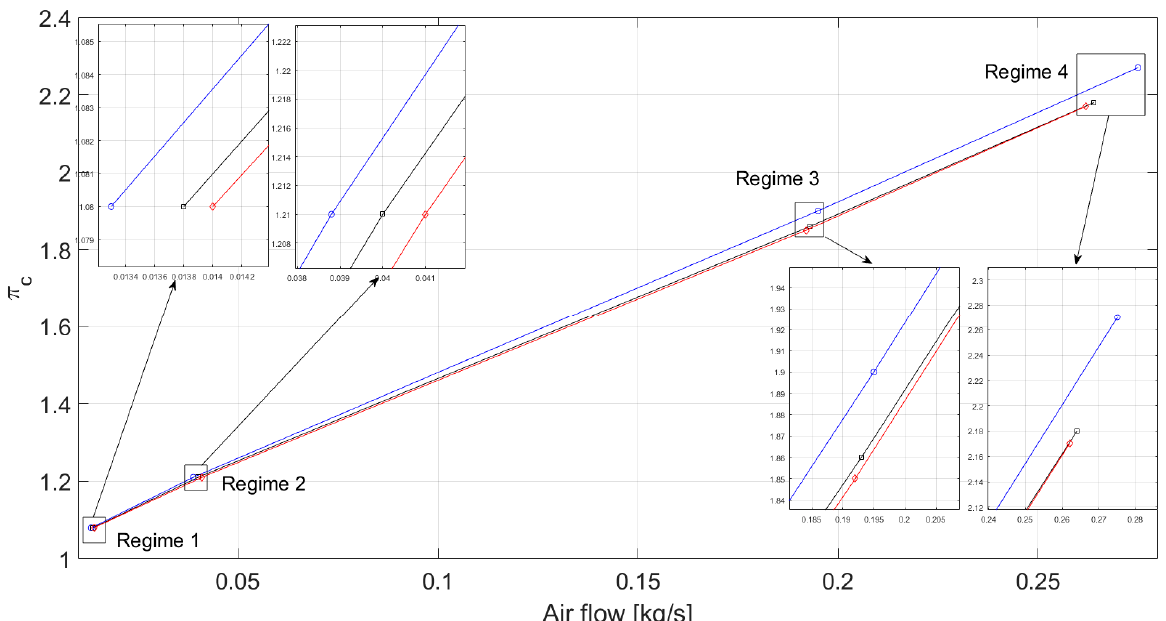
Figure 11. Variation of the compressor ratio depending on the intake air flow at constant speed.